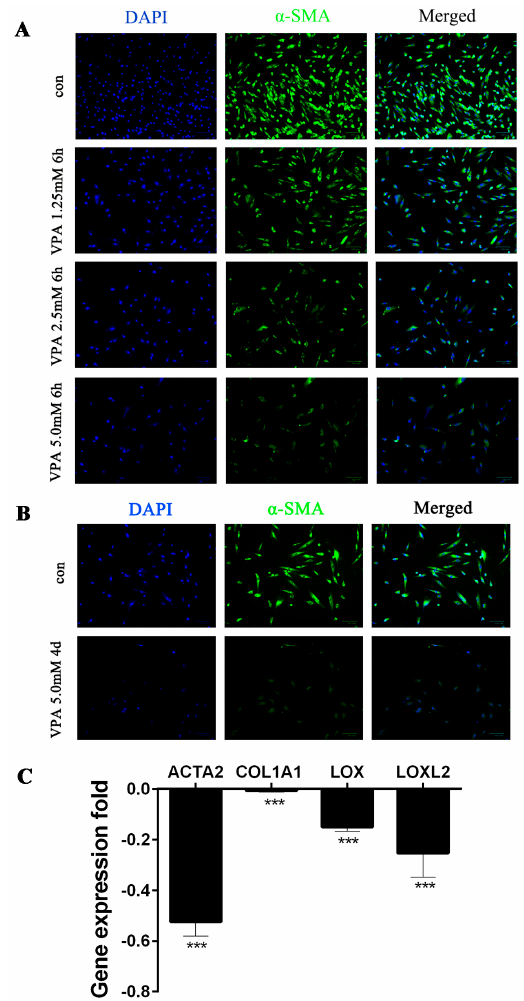
Figure 1. Valproic acid (VPA)-mediated induction of human hepatic stellate cell (hHSC) myofibroblast conversion into an inactive phenotype. Immunofluorescence microscopy for α 2 smooth muscle actin ( α -SMA) expression in hHSC myofibroblasts treated with VPA (1.25, 2.5 and 5.0 mM) for 6 h and 4 days ( A , B ). hHSCs were cultured in dulbecco’s modified eagle medium (DMEM) containing 5% fetal bovine serum (FBS) and 1% Penicillin/Streptomycin (P/S) in the presence or absence of VPA; nuclei were stained with 4 ′ ,6-diamidino-2-phenylindole (DAPI) (blue), and α -SMA is indicated as green; magnification: ×100 μ m. ( C ) Alpha 2 ( ACTA2 ), collagen type I alpha 1 chain ( COL1A1 ), lysyl oxidase ( LOX ) and lysyl oxidase like 2 ( LOXL2 ) mRNA expression folds of hHSCs treated with 5.0 mM